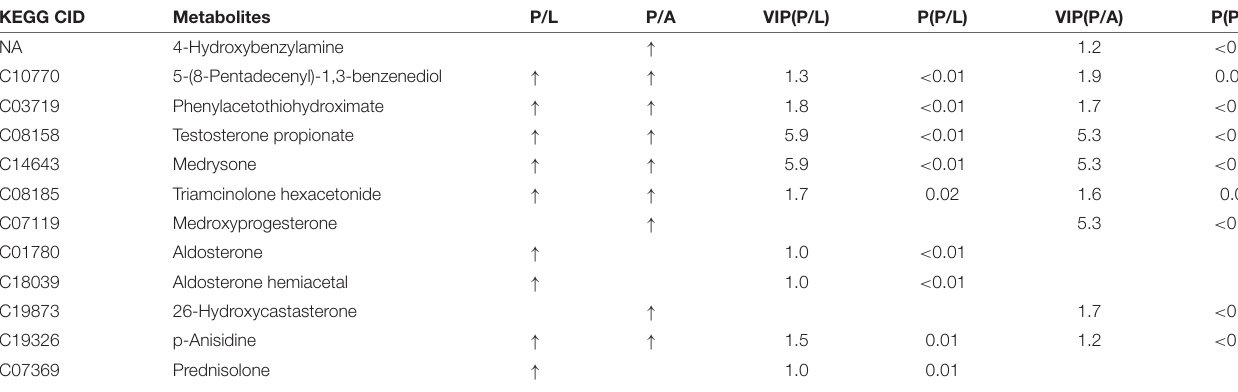
TABLE 2 | Differential xenobiotics with higher levels in pupae v.s. larvae/adults in negative ion mode.